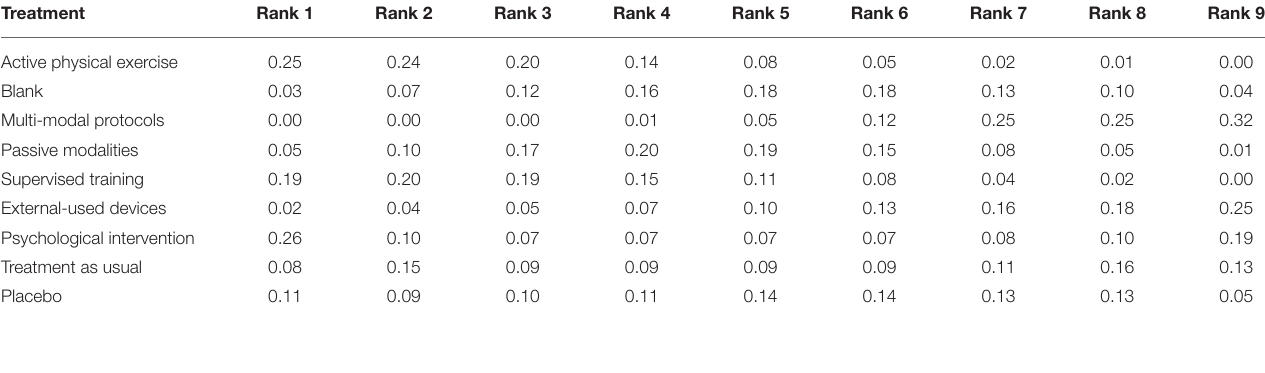
TABLE 4 | Ranking of measures and probabilities.